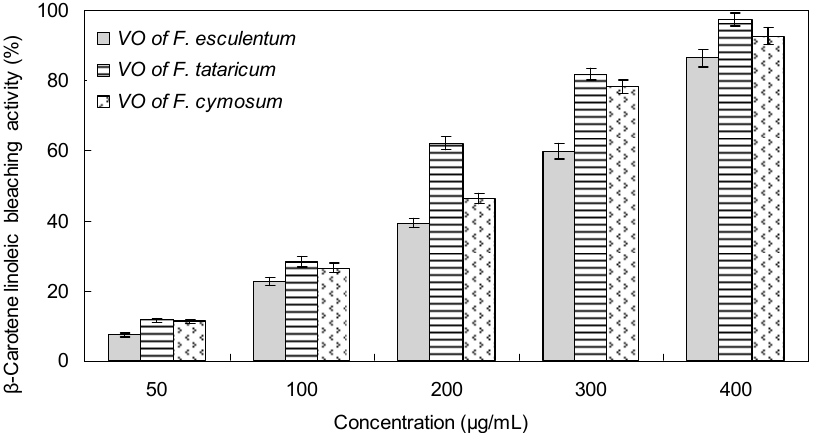
Figure 2. β -Carotene linoleic acid bleaching activity of the flower volatile oils of F. esculentum , F. tataricum and F. cymosum.